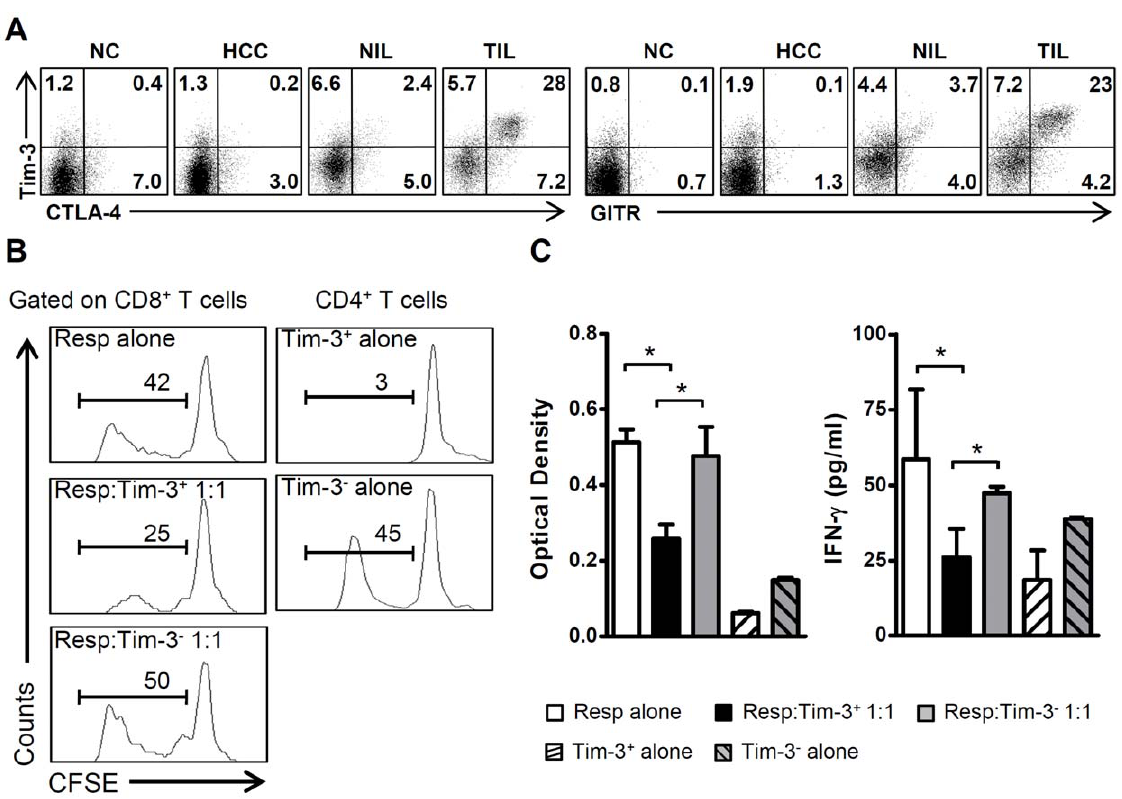
Figure 4. CD4 + Tim-3 + T cells isolated from TILs exhibit suppressive activity. A . Representative FACS analysis showing that most tumor- infiltrating Tim-3 + CD4 T cells expressed the Treg functional markers CTLA-4 (left) and GITR (right), n =6. B . CD4 + Tim-3 + T cells suppressed autologus tumor-infiltrating CD8 + T cells. CD4 + Tim-3 + , CD4 + Tim-3 2 and CD8 + T cells were sorted from TILs, and the suppression assay was performed as described in Materials and Methods. The ratios of responder to suppressor cells were indicated. Cell proliferation was tracked by monitoring the decrease in CFSE fluorescence, n =4. The numbers in the histograms indicate the percentage of proliferating cells. C . The BrdU incorporation assay supported the suppressive function of CD4 + Tim-3 + T cells isolated from TILs. IFN- c production in the indicated culture supernatants was quantified by ELISA, n =4. Bars indicate the SEM; *, P , 0.05.